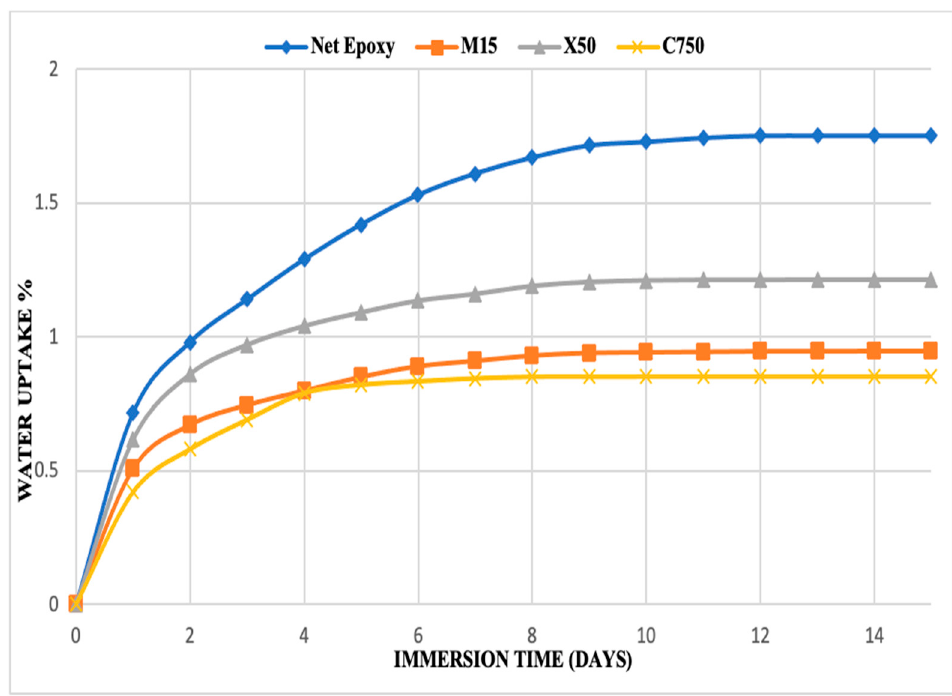
Figure 7. Time dependence of the percentage of water absorption in neat epoxy resin and epoxy composites reinforced with C750, M15, and X50 Gnps.